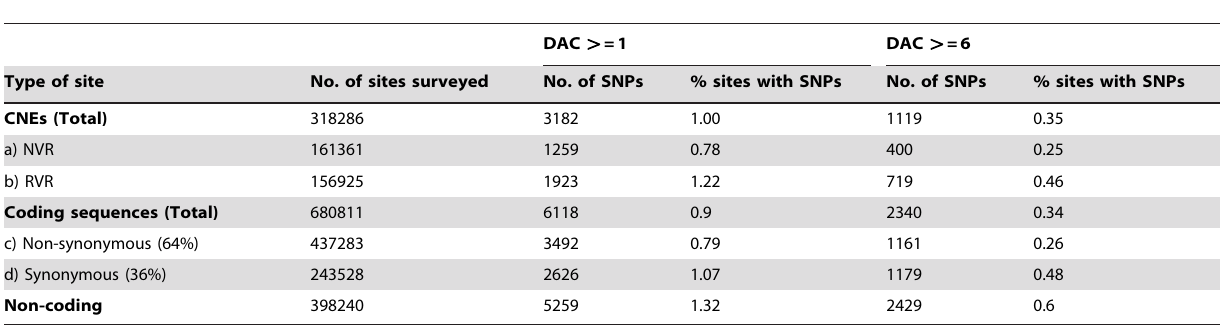
Table 2. Variants from 1000 Genomes Low Coverage Data across the different categories.